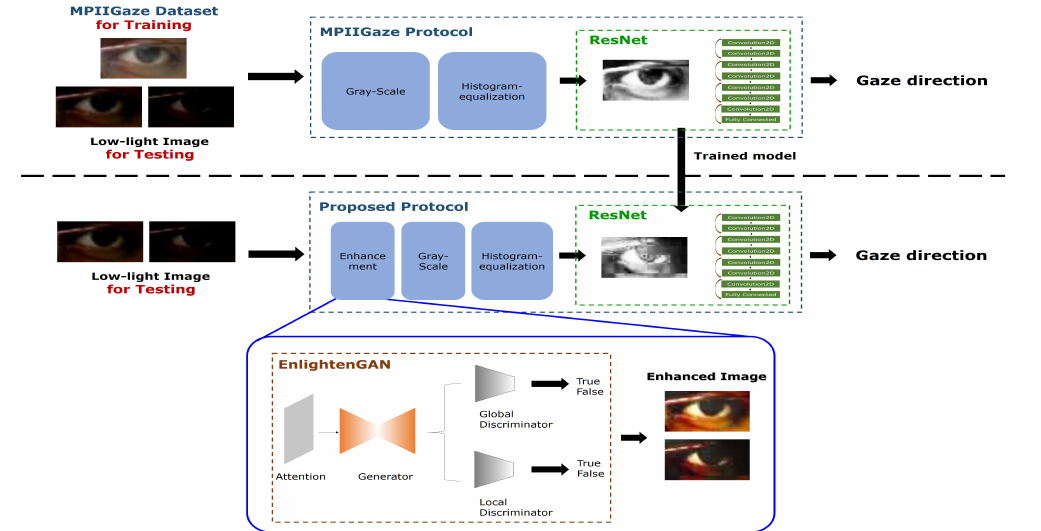
Figure 2. Overall workflow of the proposed